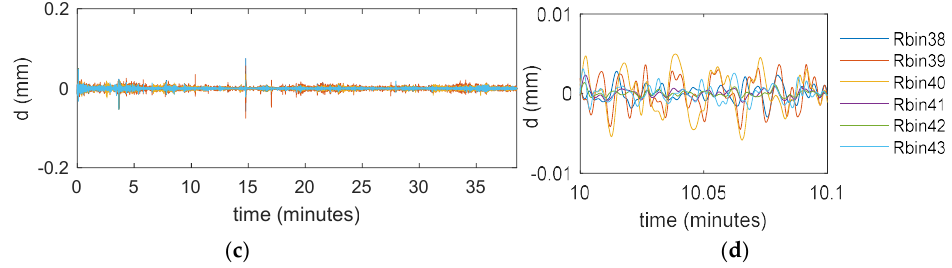
Figure 10. As-recorded time series obtained by RAR remote sensing: ( a ) the complete recording; ( b ) a six-seccond fragment. Processed time series obtained by RAR remote measurements: ( c ) the complete recording; ( d ) a six-second fragment.